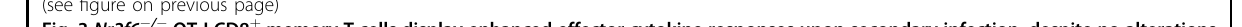
measured by lower weight loss and a 48-fold reduction in splenic CFUs (Fig. 4E, F).